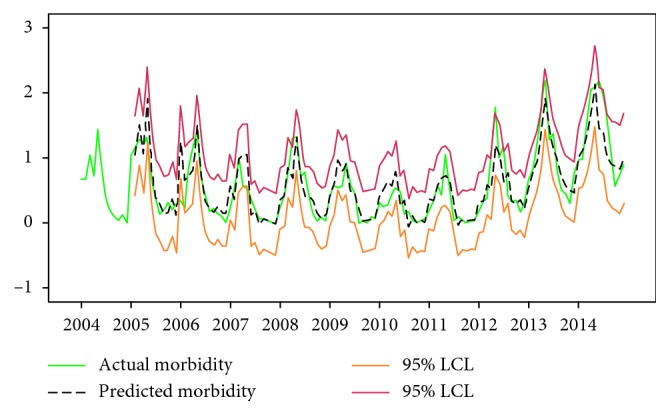
Fitting status situation between actual and predicted morbidity from 2005 to 2014. Red and orange lines indicate the upper and lower scope of 95% confidence limit of predicted incidence of brucellosis, while a green line indicates the actual incidence values and a black dotted line indicates the predicted incidence.